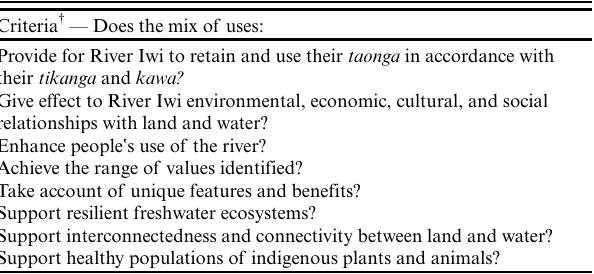
Table 1. Illustrative criteria for choosing a preferred mix of